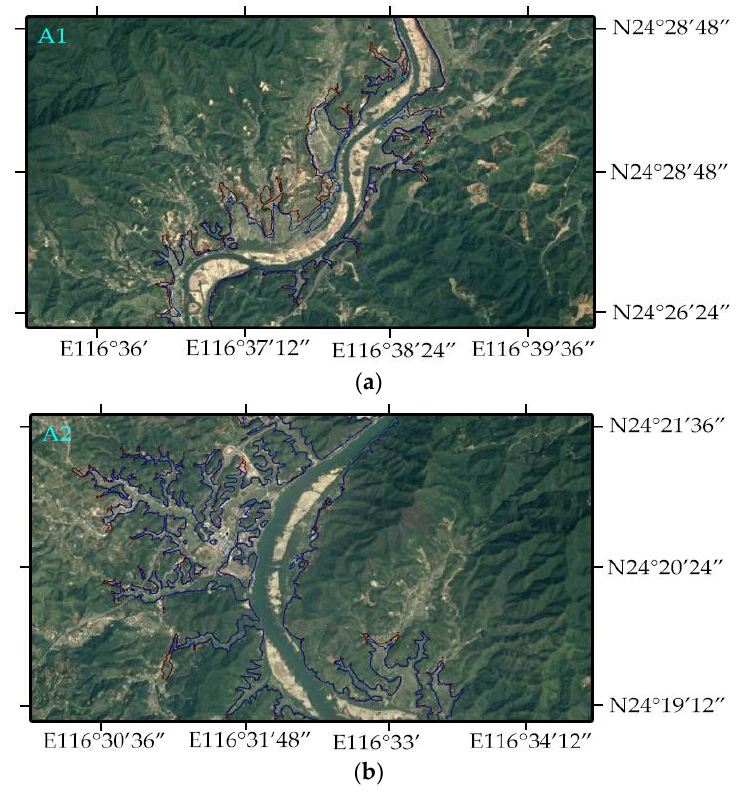
Figure 10. Inundation range of A1 and A2. ( a ) The inundation range difference in A1 section between HQ 100 and HQ 50 ; and, ( b ) The inundation range difference in A2 section between HQ 100 and HQ 50 .